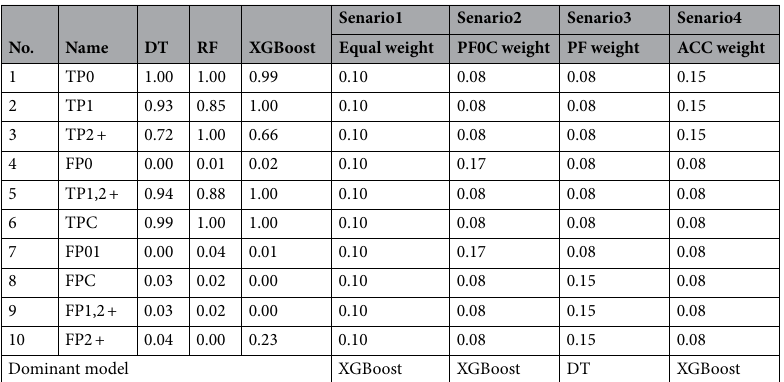
Table 8. Normalising the final measures for model comparison and weight scenarios with the most accurate model in each scenario.